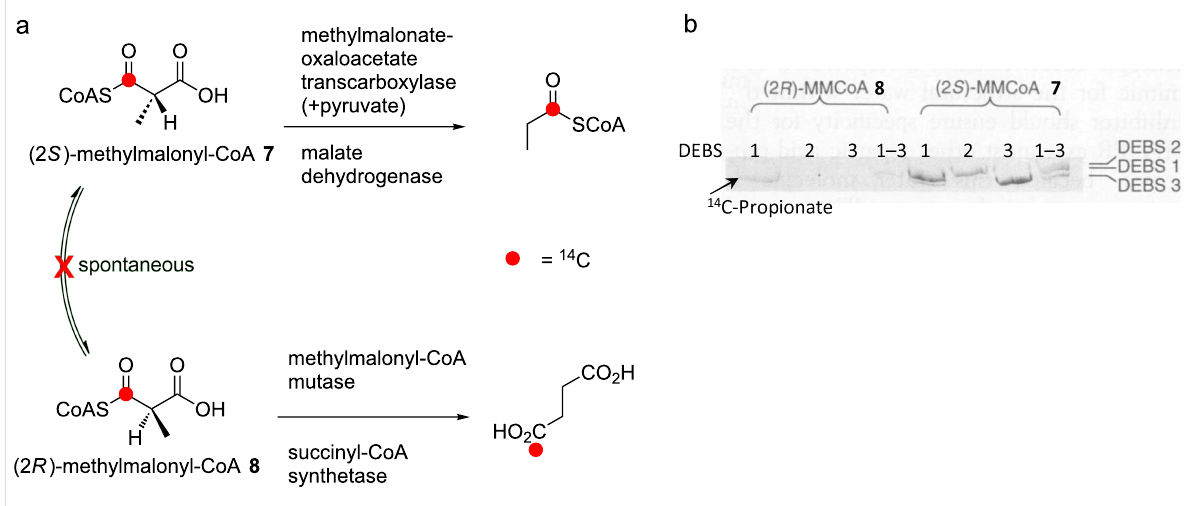
Figure 5: Determination of the stereochemistry of extender unit selection by the AT domains of modular PKS. a) Enantiomerically pure 14 C-labeled (2 S )-methylmalonyl-CoA ( 7 ) and (2 R )-methylmalonyl-CoA ( 8 ) were generated enzymatically from a racemic mixture by consumption of the opposite enantiomer under conditions designed to minimize spontaneous epimerization. b) Results of labeling of the DEBS proteins with pure 14 C-(2 R )- or (2 S )-methylmalonyl-CoA. Only incubation with (2 S )-methylmalonyl-CoA ( 7 ) produced radioactive labeling of the three DEBS proteins (the signal ob- tained for DEBS 1 with (2 R )-methylmalonyl-CoA ( 8 ) is due to the presence of a small amount of propionyl-CoA contaminant, which labeled the loading module. Image adapted from [26].